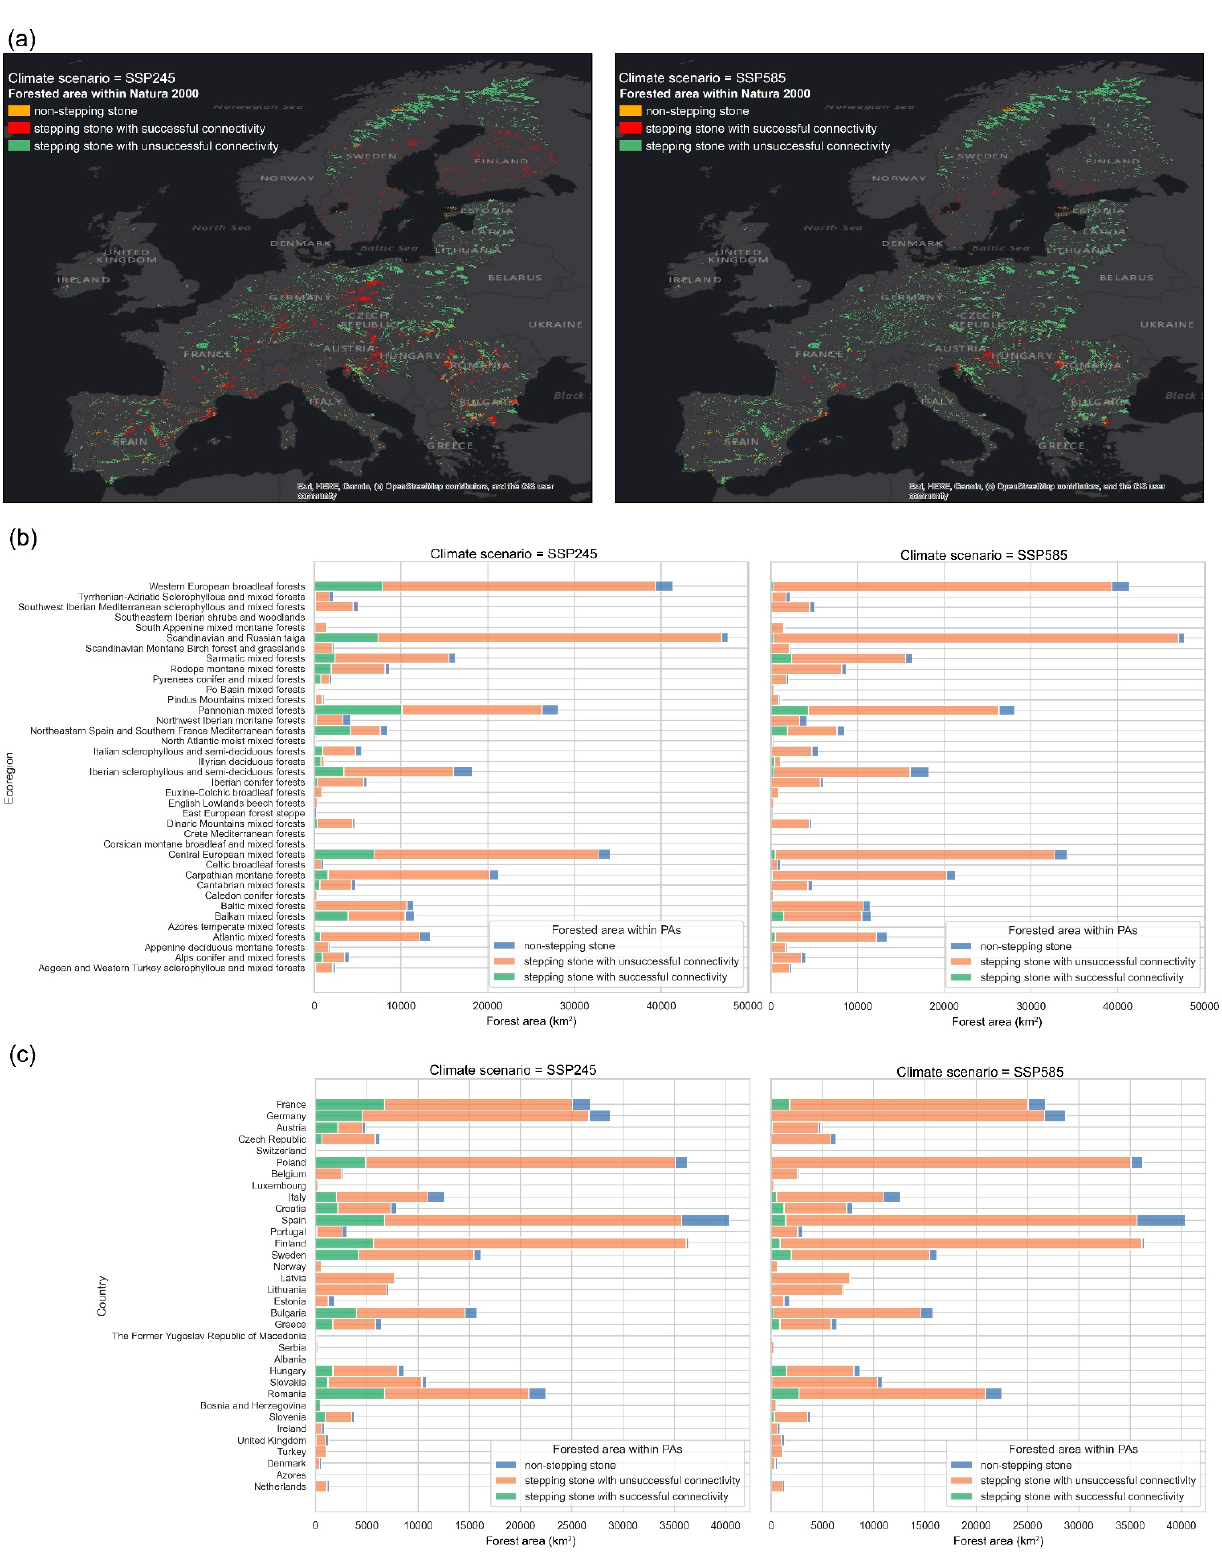
Figure 6. Forested areas within Natura 2000: ( a ) maps of stepping-stone and non-stepping-stone forests within protected areas under climate scenarios SSP245 and SSP585; ( b ) the total area of forests in each ecoregion, classified by non-stepping stones, stepping stones with successful climate connectivity, and stepping stones with unsuccessful climate connectivity; ( c ) the total area of forests in each country, classified by non-stepping stones, stepping stones with successful climate connectivity, and stepping stones with unsuccessful climate connectivity.